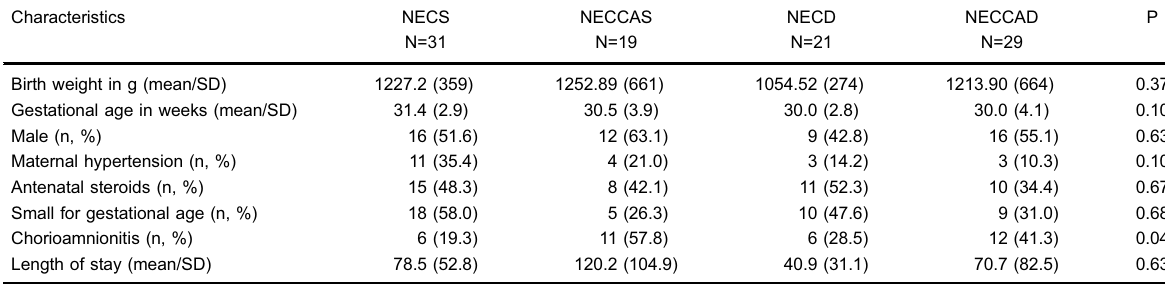
Table 1. Characteristics of the studied groups according to the presence of heart disease and type of surgical treatment.